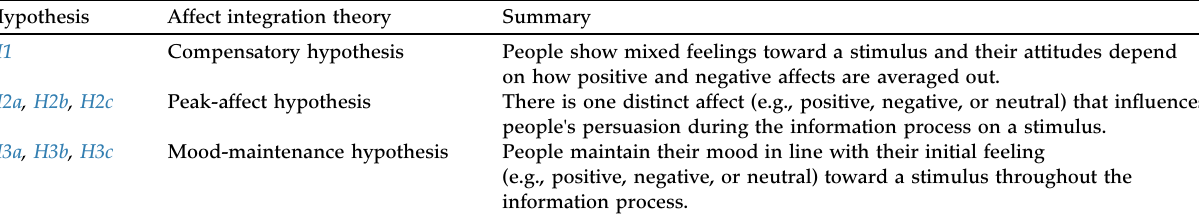
Table 1. A summary of research